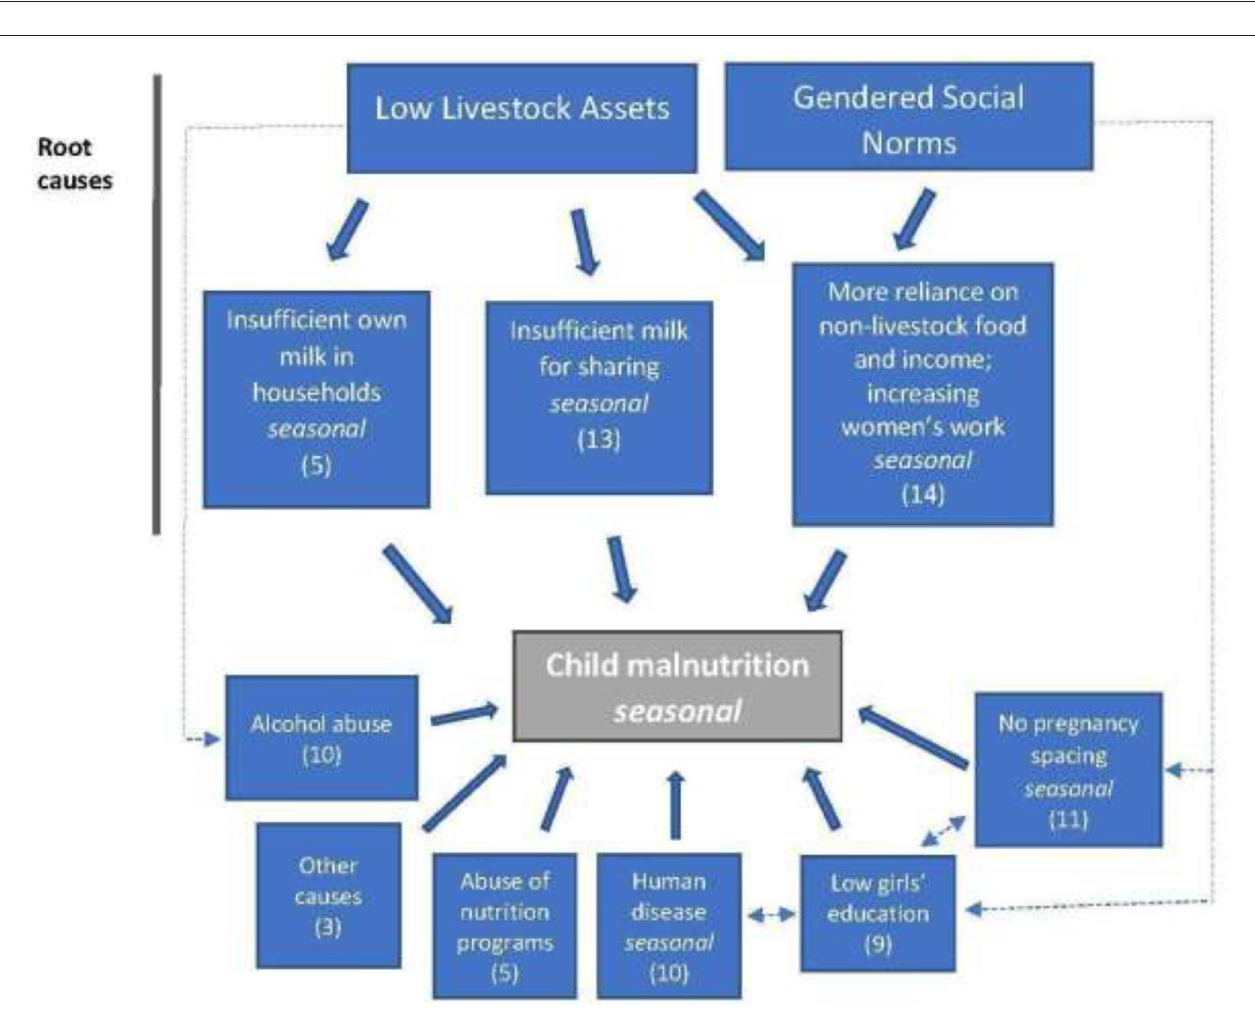
FIGURE 3 | Example of a causal diagram for child malnutrition, Karamoja, Uganda, 2018. The numbers in the boxes are the median scores for the relative importance of the causal factors.